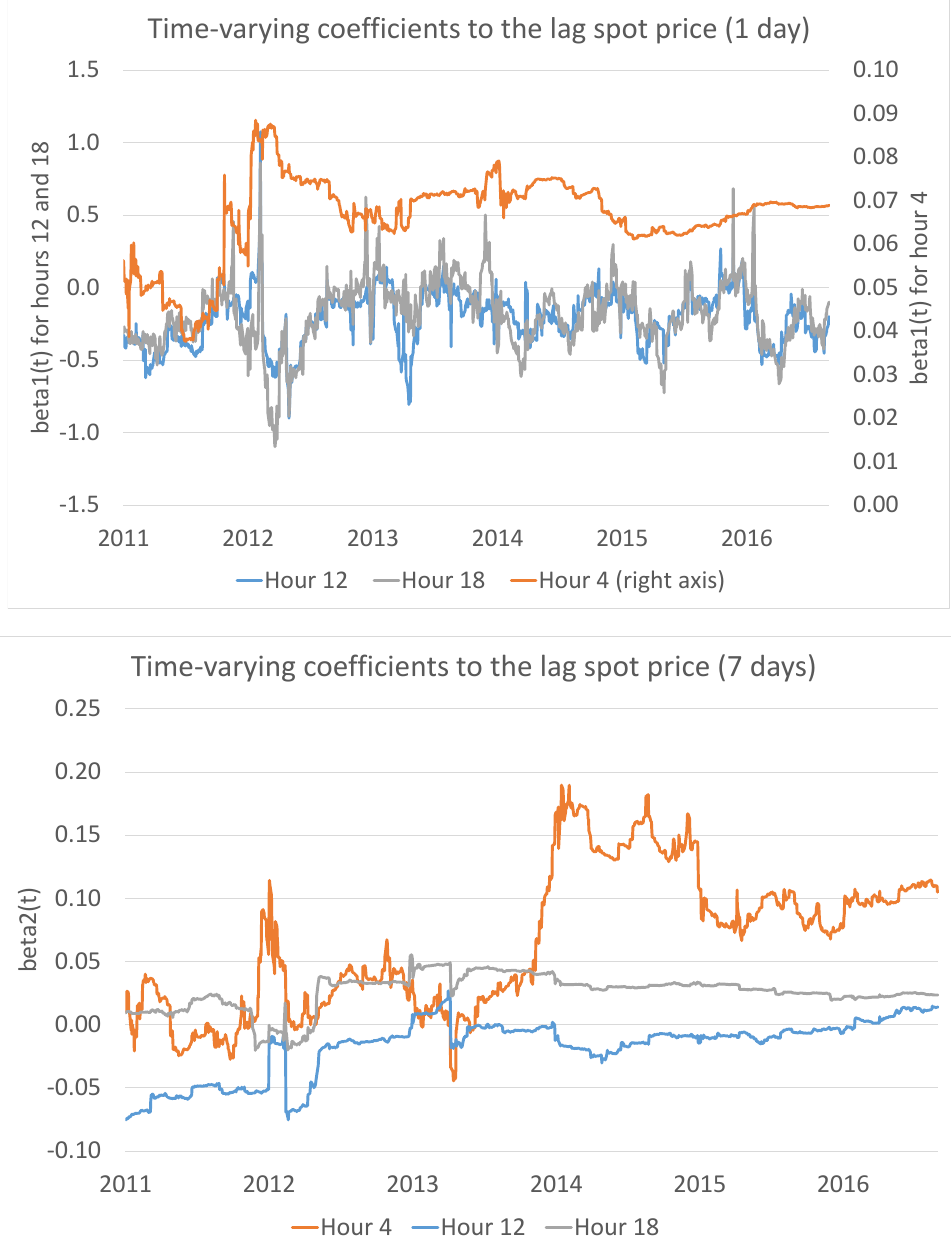
Figure 5. Time-varying coefficients of the one-day lagged price (same hour, previous working day) and the 7-day lagged price (same hour, one week ago). The coefficients have been estimated for working days during the sample period from 1 January 2011 until 31 August 2016 with respect to the key hours H4, H12 and H18. Observations of the year 2010 have been used for an initial estimation of the unknown covariances R and Q . Note that, in the upper graph, the values of H4 are scaled on the right